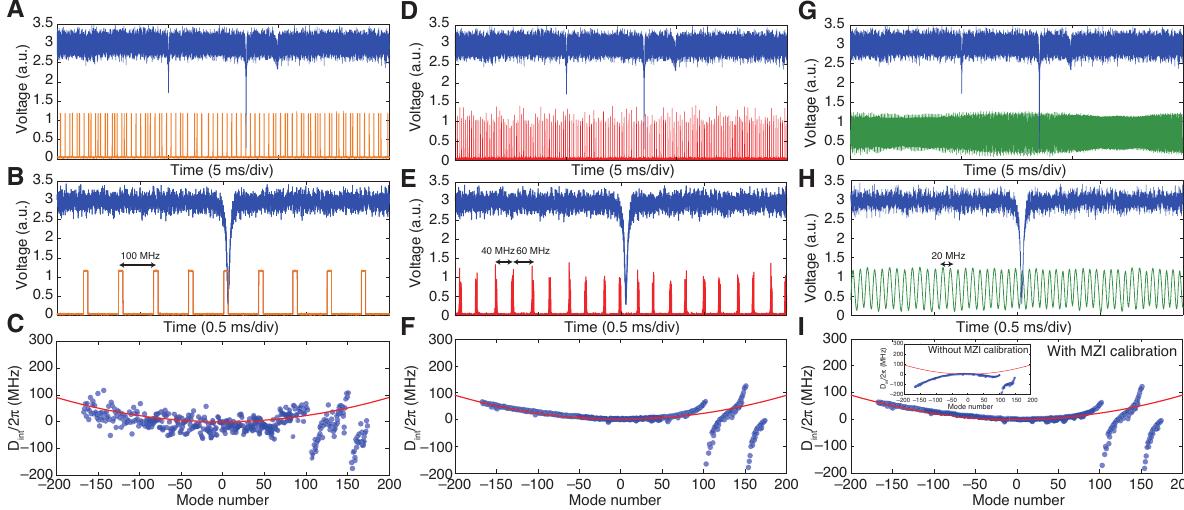
Figure 11: Comparison of dispersion measurement results obtained with three different methods. (A) Measured resonator transmission spectrum (blue) and frequency marker signal with wavelength meter (orange). Several different mode families are recorded. (B) 10 × enlarged view of (A). The frequency axis is calibrated by the peaks at a 100 MHz distance. (C) Measured dispersion plot of D (blue dots) versus relative mode number μ . The red line shows a parabolic fitting curve yielding D int (FSR ~ 21.6 GHz). The deviations from the fitting are limited by the accuracy of the wavelength meter. Strong mode perturbations around μ = 100 and μ = 150 are caused by anti-mode crossing between different mode families. (D) Measured resonator transmission spectrum (blue) and beat signal (red) with fiber comb lines, which work as calibration peaks. (E) 10 × enlarged view of (D). The frequency axis is calibrated by the peaks at 40 MHz and 60 MHz with respect to the fiber comb lines with a 100 MHz mode spacing. (F) Measured dispersion plot of D (blue dots) and fitting curve (solid red line). The measurement accuracy is greatly improved compared with the wavelength meter int method. (G) Measured resonator transmission spectrum (blue) and interferometric signal (green) with a fiber MZI. (H) 10 × enlarged view of (G). The frequency axis is calibrated by the sinusoidal peaks at 20 MHz of FSR of the MZI. (I) Measured dispersion plot of D and fitting curve (solid red line). With proper dispersion calibration of the fiber MZI, the measured dispersion agrees well with the results obtained with other methods. The inset shows the result without MZI calibration, which reflects the inherent dispersion of silica optical fiber, and it hinders the resonator